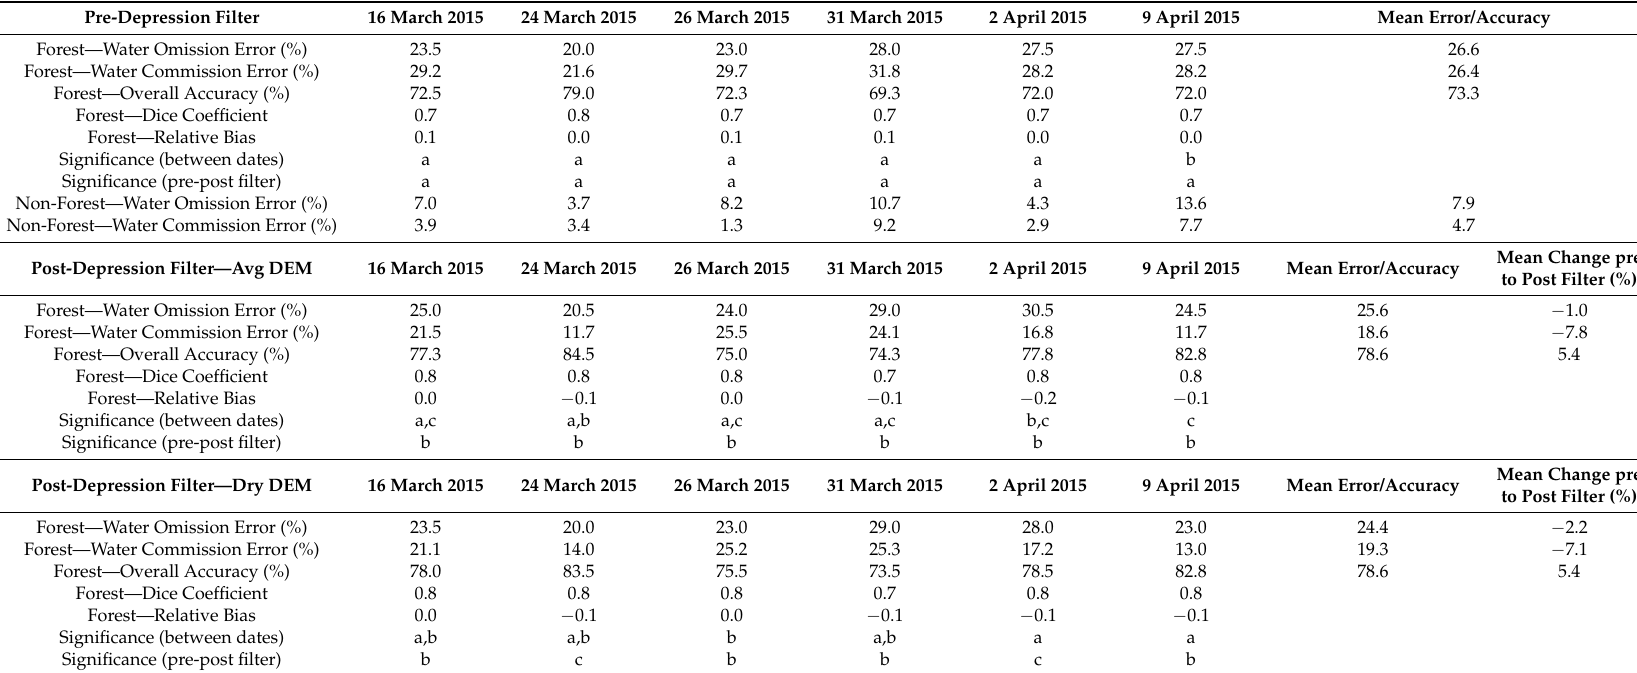
Table 5. The accuracy of surface water maps within forest derived from Radarsat-2 imagery for each of the six dates, pre and post-depression filter derived using lidar digital elevation models (DEMs) collected in both dry and average wetness conditions. The errors of omission and commission for water in non-forest cover types are also provided for reference. Significance was determined using McNemar’s chi-squared test with continuity correction. Different letters indicate significant